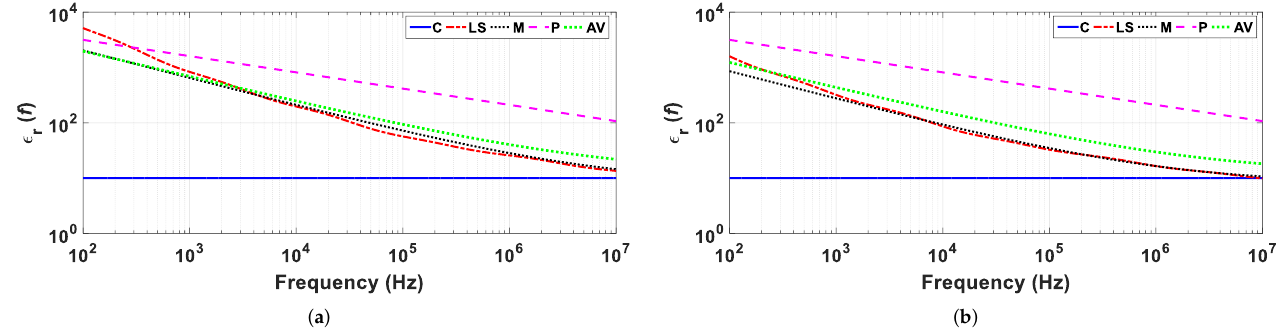
Figure 1. Relativity permittivity as a function of frequency with ρ 0 of: ( a ) 700 Ω · m and ( b ) 4000 Ω · m.